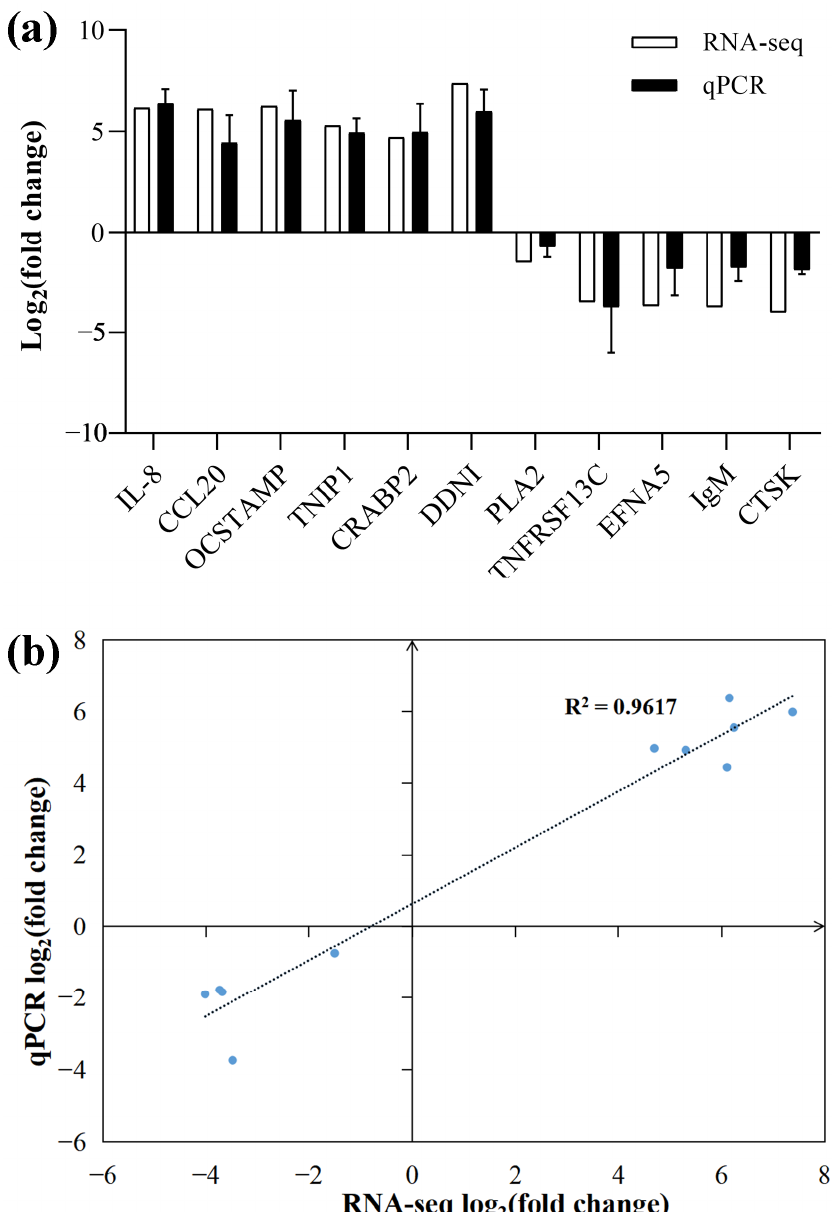
Figure 8. ( a ) Comparative analysis of RNA-seq data and qPCR at the transcript level. The standard deviations of the mean values from three qPCR replicates are visualized using error bars. ( b ) The linear regression of log 2 (fold-change) between qPCR data and RNA-seq data.